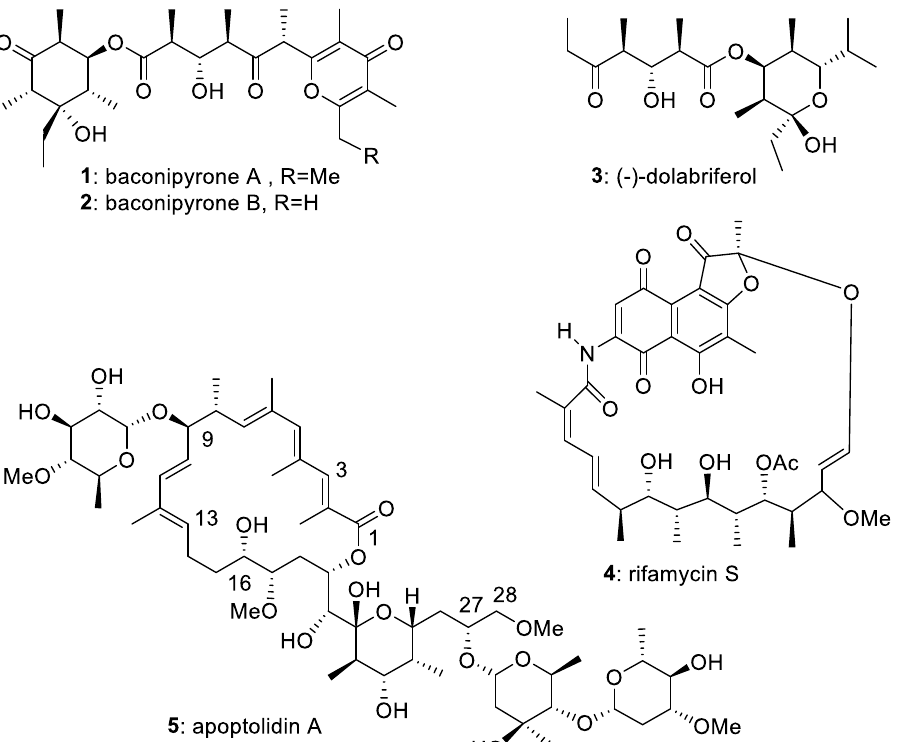
Figure 1. Examples of natural products containing polypropionate fragments, their synthesis being presented in this report.